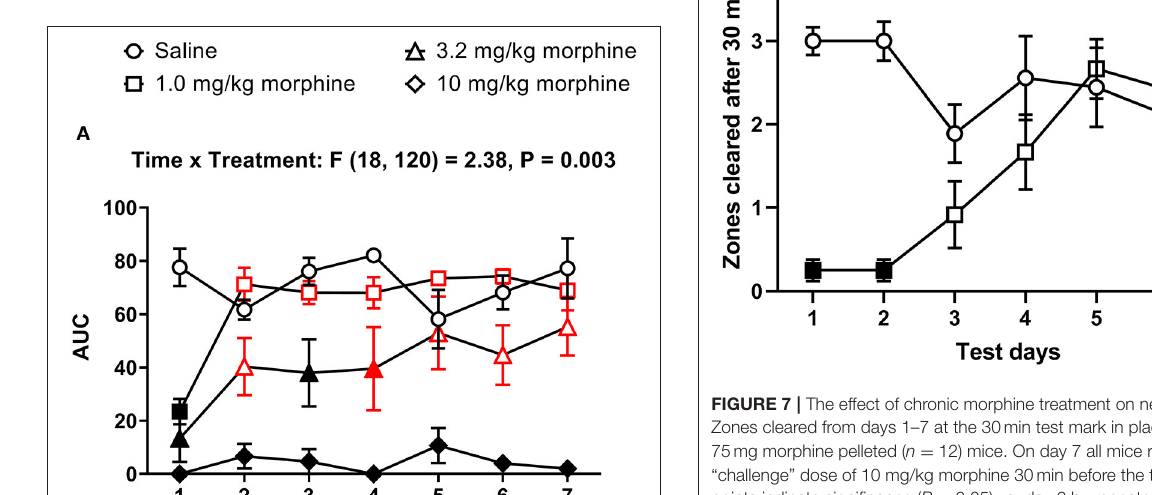
FIGURE 7 | The effect of chronic morphine treatment on nesting behavior. Zones cleared from days 1–7 at the 30min test mark in placebo ( n = 9) and 75mg morphine pelleted ( n = 12) mice. On day 7 all mice received a “challenge” dose of 10 mg/kg morphine 30min before the test period. Red points indicate significance ( P < 0.05) vs. day 6 by repeated measures two-way ANOVA with Bonferroni’s test. Filled points indicate significance vs. placebo indicated by a significant time x treatment interaction by repeated measures two-way ANOVA with Bonferroni’s test. Figure 6 shows the percent change in body weight of mice treated daily with saline or morphine (1.0, 3.2 or 10 mg/kg). Morphine-treated mice had reduced body weights compared to saline-treated animals [Treatment effect: F (3, 20) =